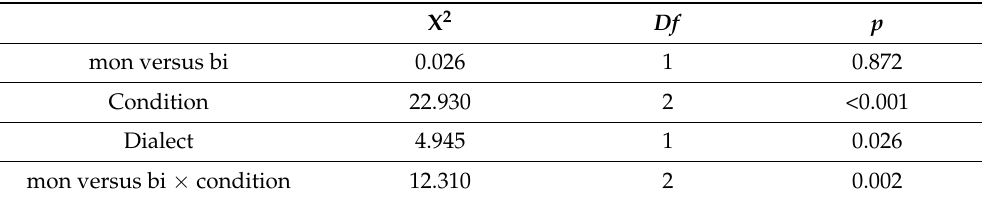
Table 4. Analysis of deviance table (Type II Wald chi-square tests) for the fixed effects tested in the accuracy experiment. The model includes monolinguals and bilingual